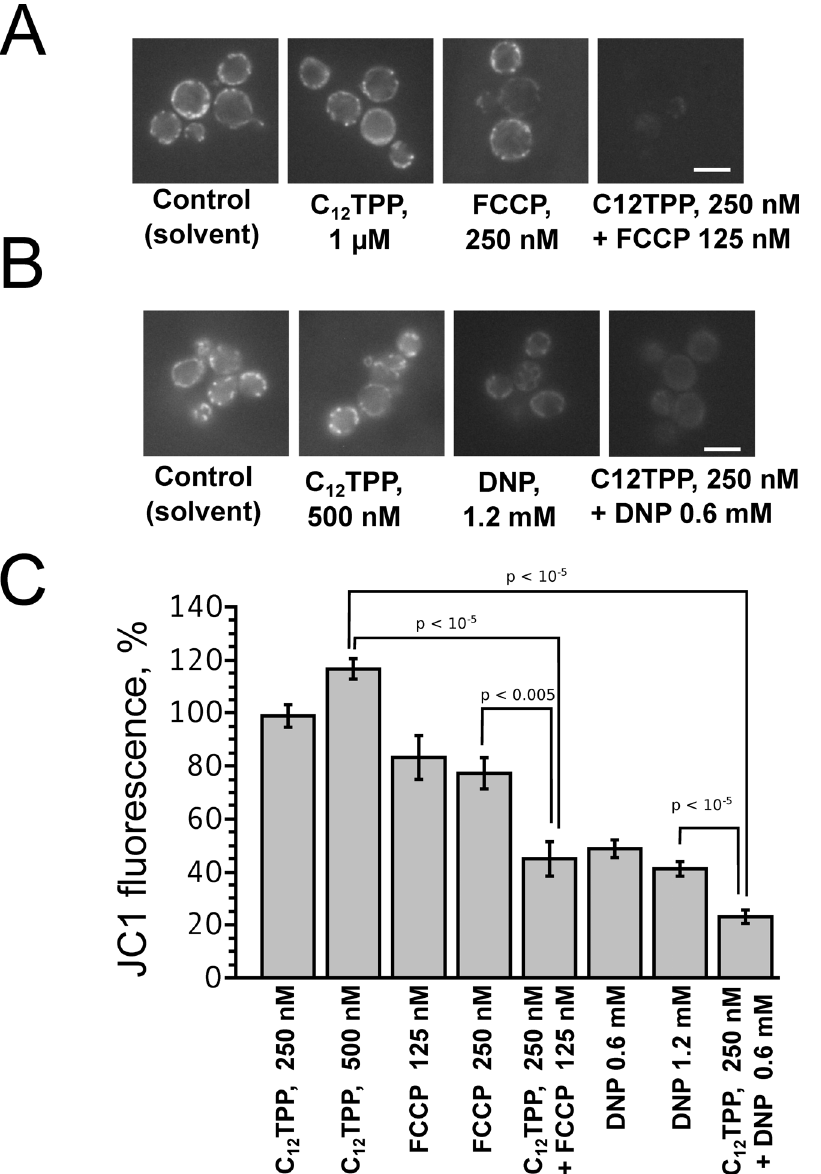
Figure 8. C 12 TPP augments the FCCP- and DNP-induced decrease of mitochondrial membrane potential ( DY ) in intact yeast cells. Mitochondrial membrane potential in yeast was estimated by staining cells with the DY probe JC-1. S.cerevisiae cells were incubated with C 12 TPP and/or FCCP (A), C 12 TPP and/or DNP (B) and then loaded with 2 m M JC-1. (C) Levels of JC-1 fluorescence in yeast cells (see Material and Methods). Data are presented as averages with standard errors. Samples were compared by Wilcoxon signed ranked unpaired test. Results of at least three experiments performed on separate days (number of cells, from 30 to 170). Bar, 5 m m.